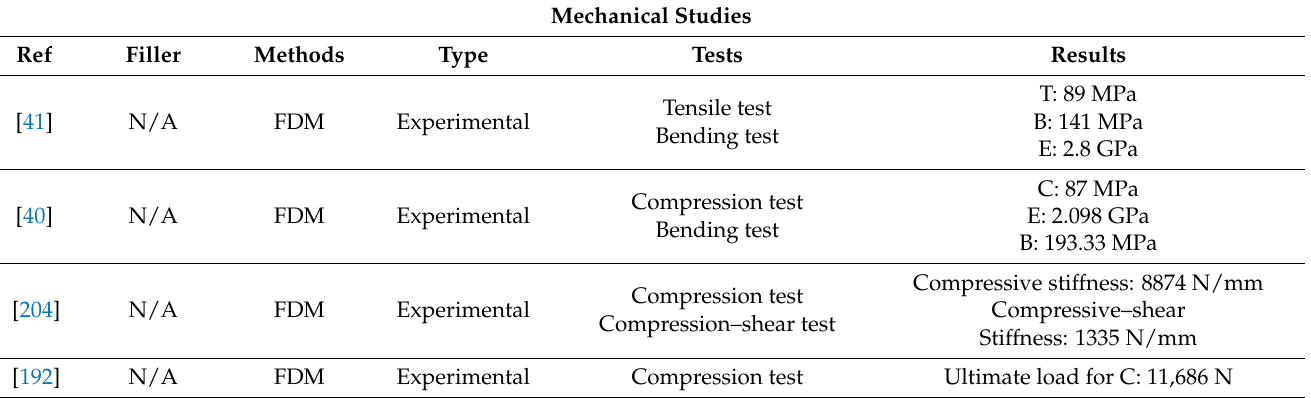
Table 13. Mechanobiological literature of PEEK and its composite material; C: compressive strength, T: tensile strength, D: displacement, Y: yield strength, E: modulus of elasticity, WCA: water contact angle, B: bending strength, R: roughness, Tr: